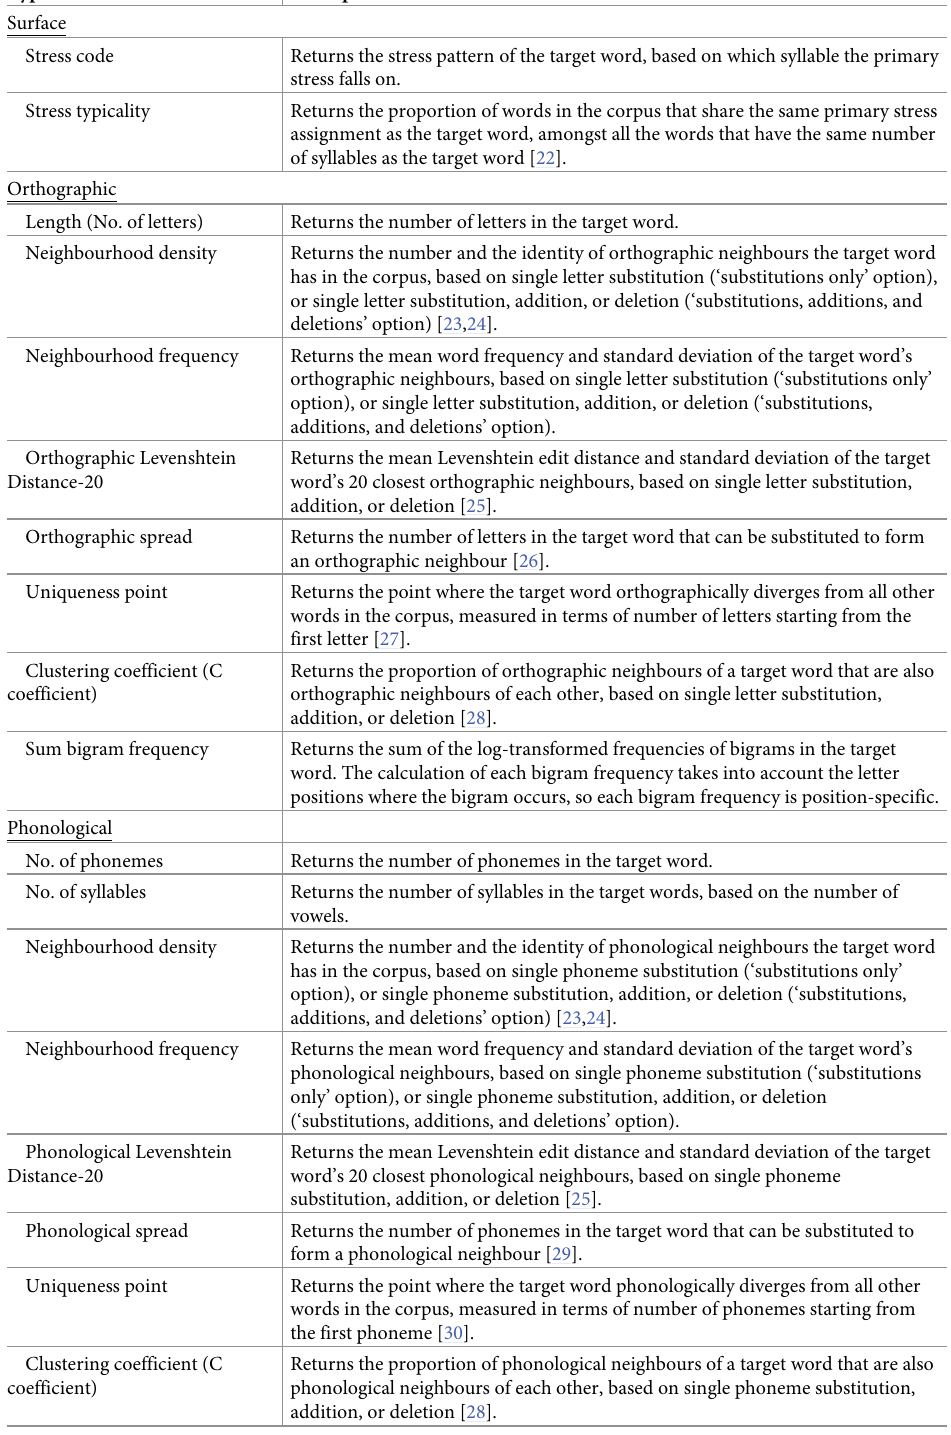
Table 2. Description of the type of metrics available in